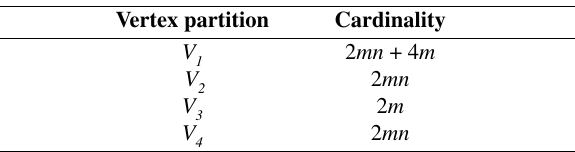
Table 1: The vertex partitions of the TiO their